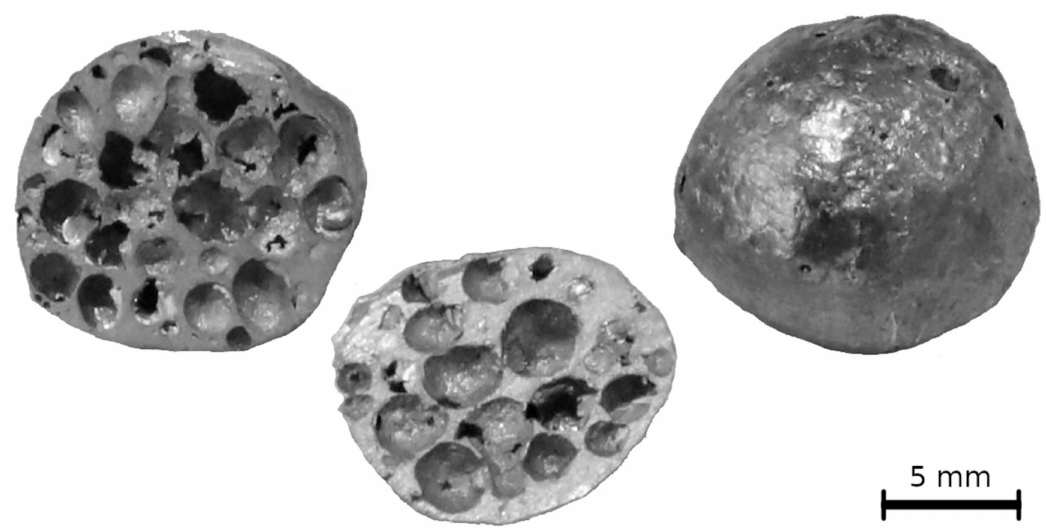
Figure 1. APM foam elements used in the